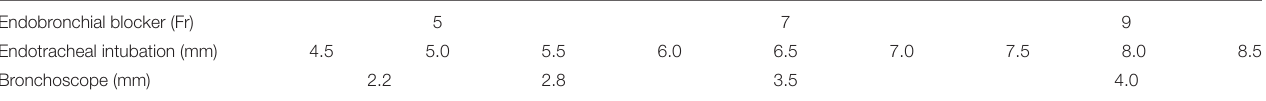
TABLE 1 | Different models of endobronchial blocker have clear matching endotracheal intubation diameter and fiberoptic bronchoscope specification. Endobronchial blocker (Fr)